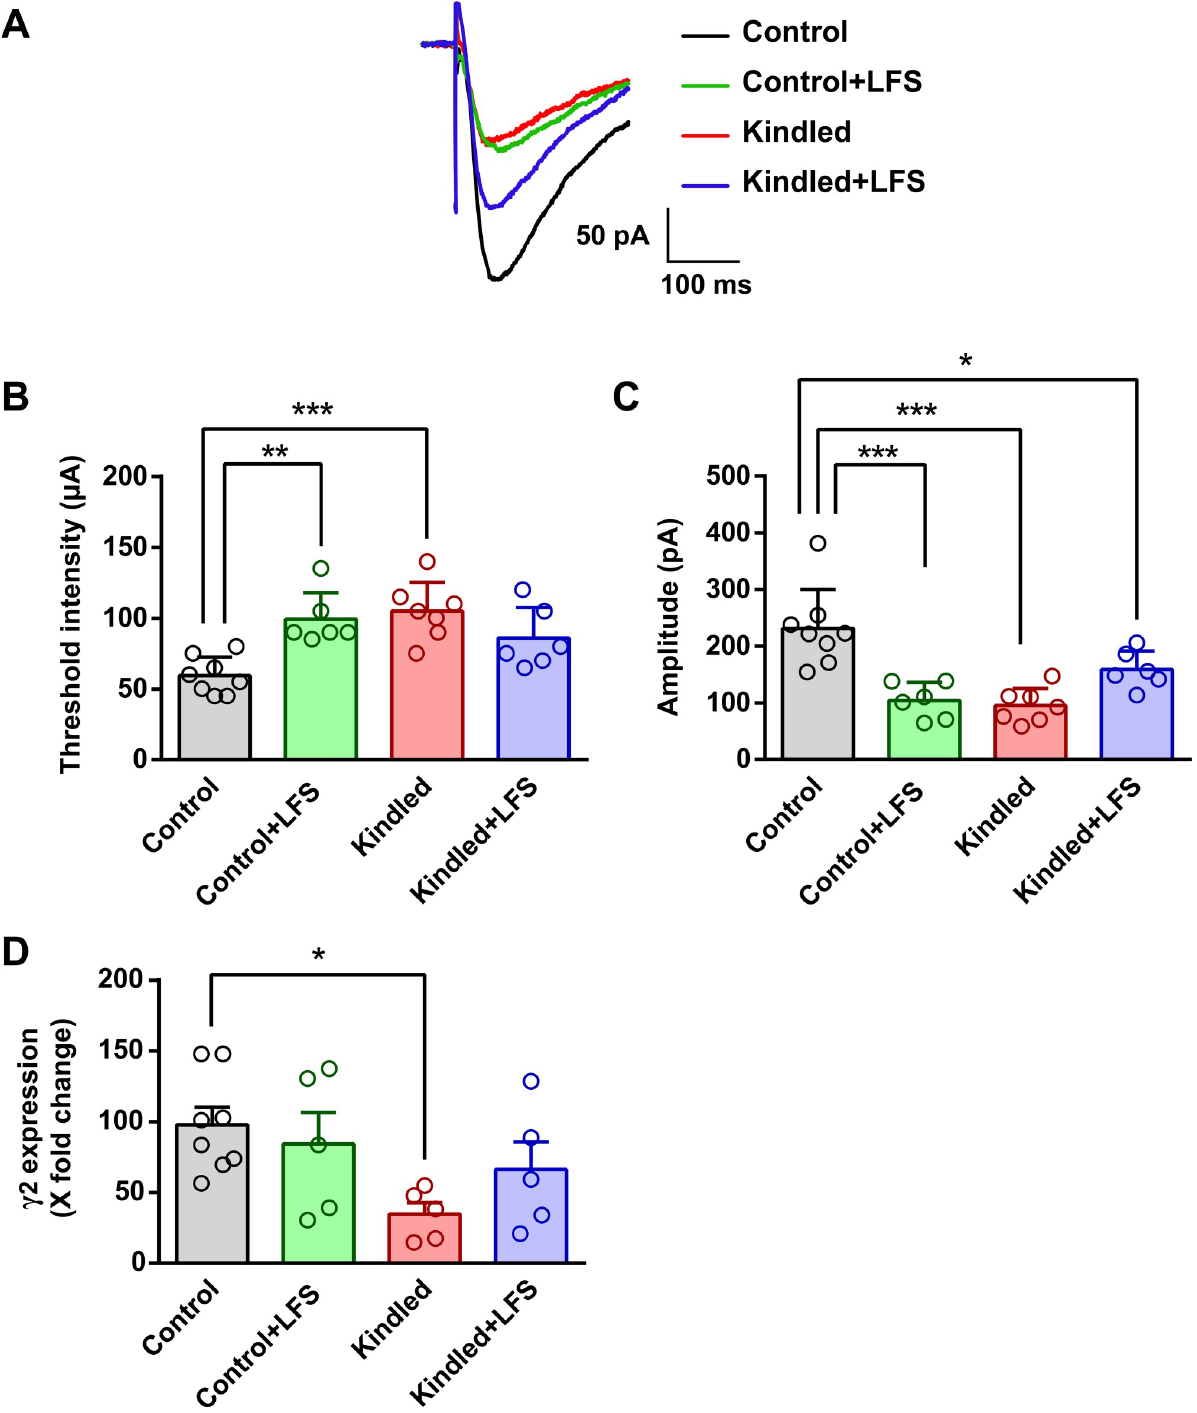
Fig 6. Effect of LFS on currents and gene expression of GABAergic receptors. (A) Sample recording of evoked IPSCs in different experimental groups. (B) Effect of LFS on the threshold intensity of EPSCs in different experimental groups. There was a significant increase in threshold intensity of IPSCs in the kindled group compared to the control group. Application of LFS in kindled animals reduced the IPSC threshold and there was no significant difference in threshold intensity between the kindled+LFS and control group. Threshold intensity in LFS group significantly increased compared to the control group. Control: n = 8, Control+LFS: n = 6, Kindled: n = 7, Kindled+LFS: n = 6. (C) Effect of LFS on the amplitude of IPSCs in different experimental groups. The amplitude of IPSCs was significantly decreased in the kindled and LFS groups compared to the control group. LFS application in kindled animals had no effect on this parameter and there was a significant difference between the kindled+LFS and control groups.